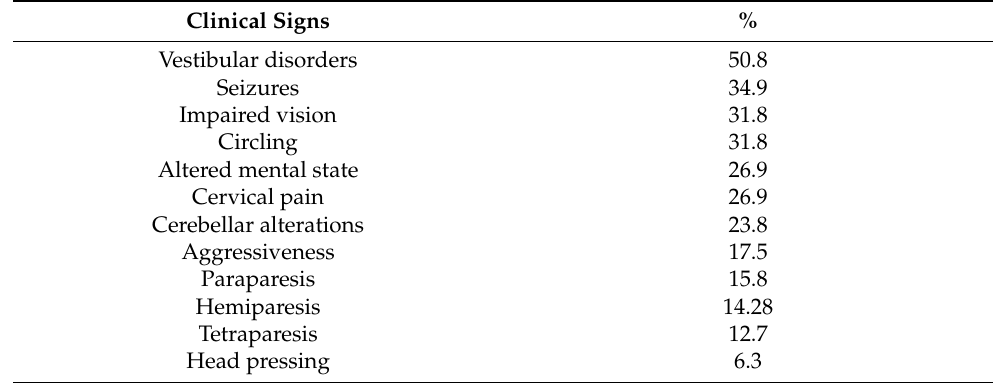
Table 1. Neurological signs observed in dogs in the meningoencephalitis of unknown origin (MUO) group.